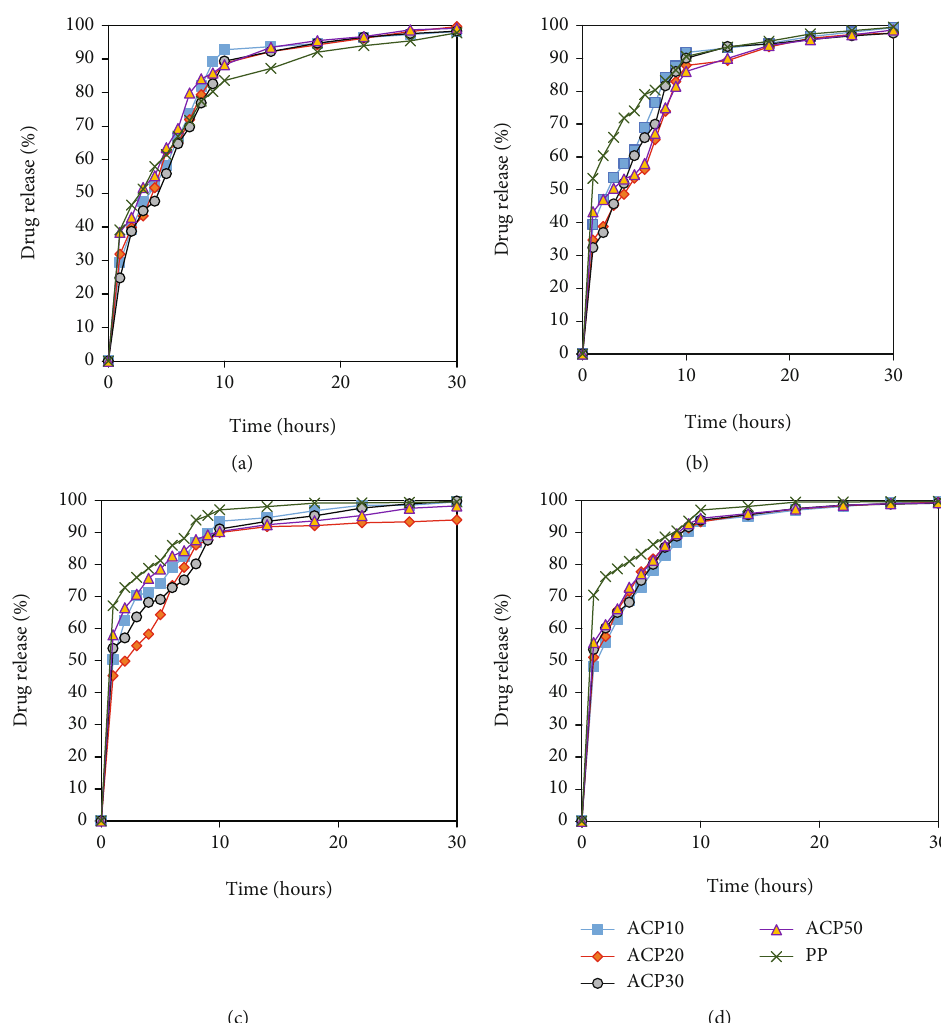
Figure 6: Content of PP released from the AGN/CS/PP nanoparticles in the di ff erent pH solutions: pH 2 (a), pH4.5 (b), pH 6.8 (c), and pH 7.4